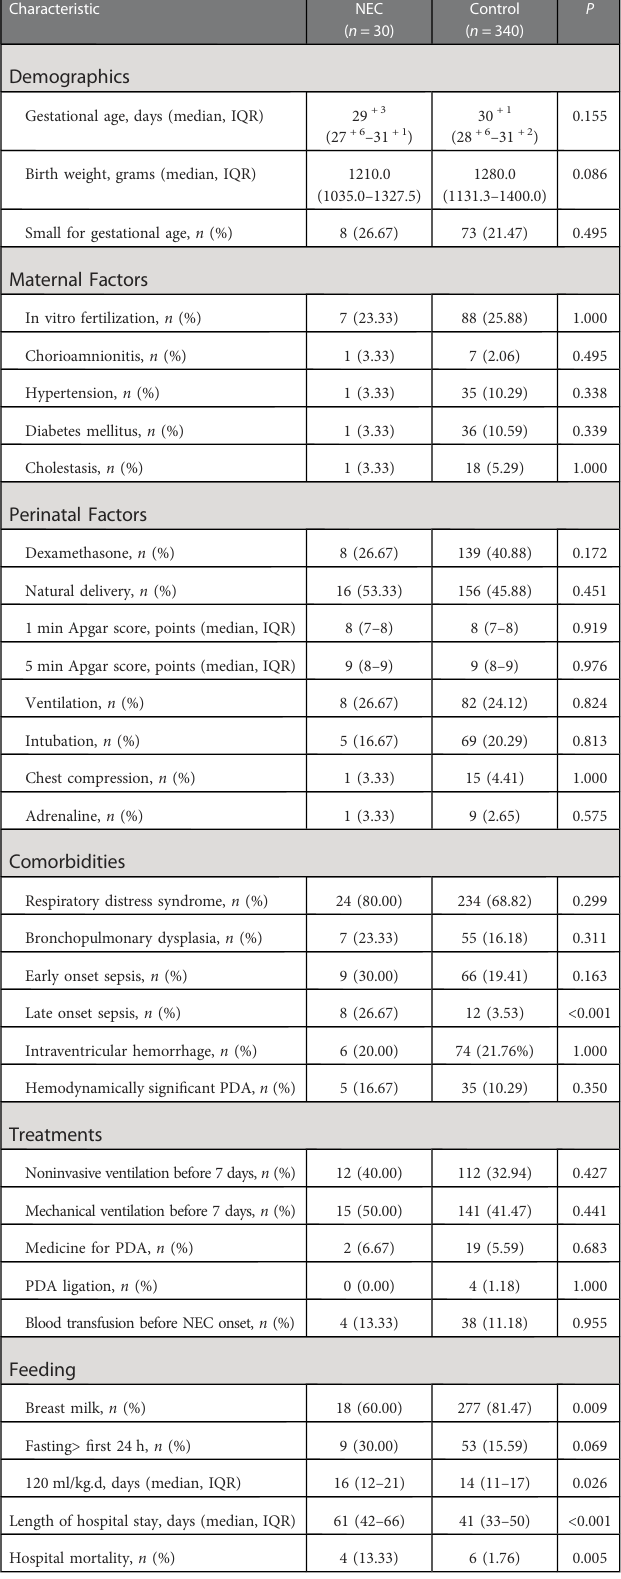
TABLE 1 Demographic, obstetric, and